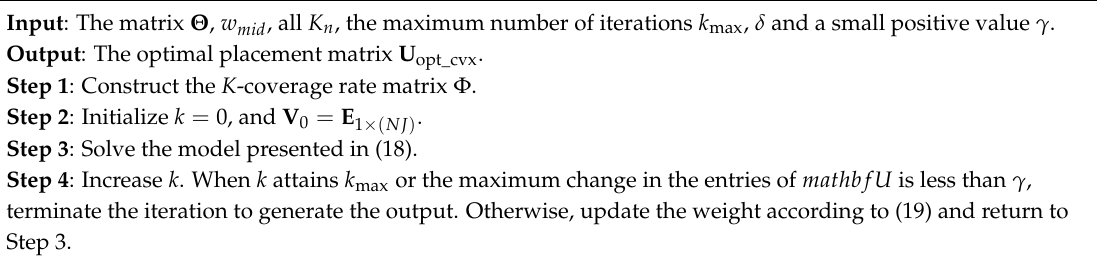
Algorithm 2: The sparsity enhancing iterative algorithm for solving